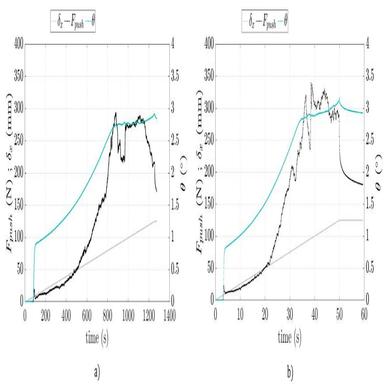
Evolution of the contact angle and Fpush in flexible bonded joints tested at (a) 6 mm/min and (b) 150 mm/min with the WDT+.